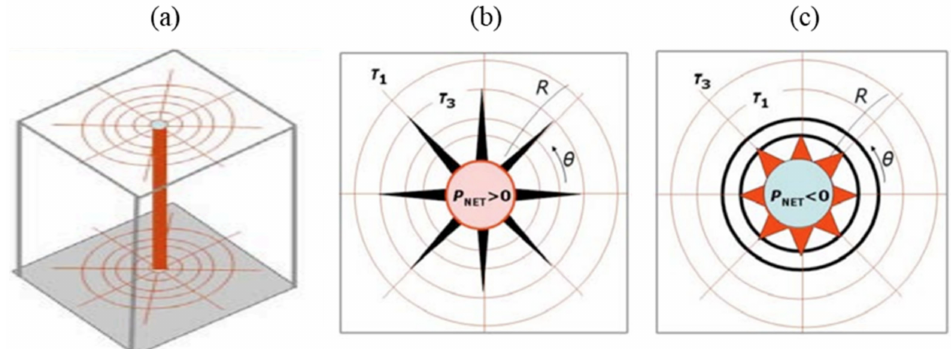
Figure 10. ( a ) Vertical wellbore penetrating horizontally layered sedimentary sequence with no tec- tonic stress component. ( b ) Spider web stress trajectory pattern around over-pressured (overbalanced) wellbore. The direction of preferred tensional failure (incipient fractures indicated by black spikes) is parallel to the largest principal stress trajectories (deviatoric compression τ 1 = σ 1 − P ), normal to the least principal stress trajectories (deviatoric tension, τ 3 = σ 3 − P ). Breakout cannot occur, due to unfavorable shear stress orientations. ( c ) Stress trajectory patterns around under-pressured wellbore. The direction of preferred tensional failure (solid black circles) follows concentric rings, due to a reversal of the principal stresses around under-pressured (underbalanced) wellbores. Breakouts may occur in all radial directions, due to favorable shear stress orientations. Modified from Weijermars and Schultz-Ela